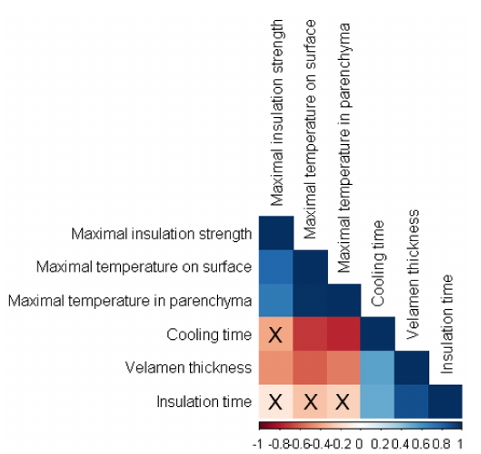
Figure A1. Regression analyses between velamen thickness of 16 epiphytic species and their thermal insulation traits. The color gradient on the x-axis indicates the correlation intensity between the variables in rows and columns, i.e., when correlations are directly proportional (blue), or inversely proportional (red). Crossed-out fields indicate lack of significance ( p >